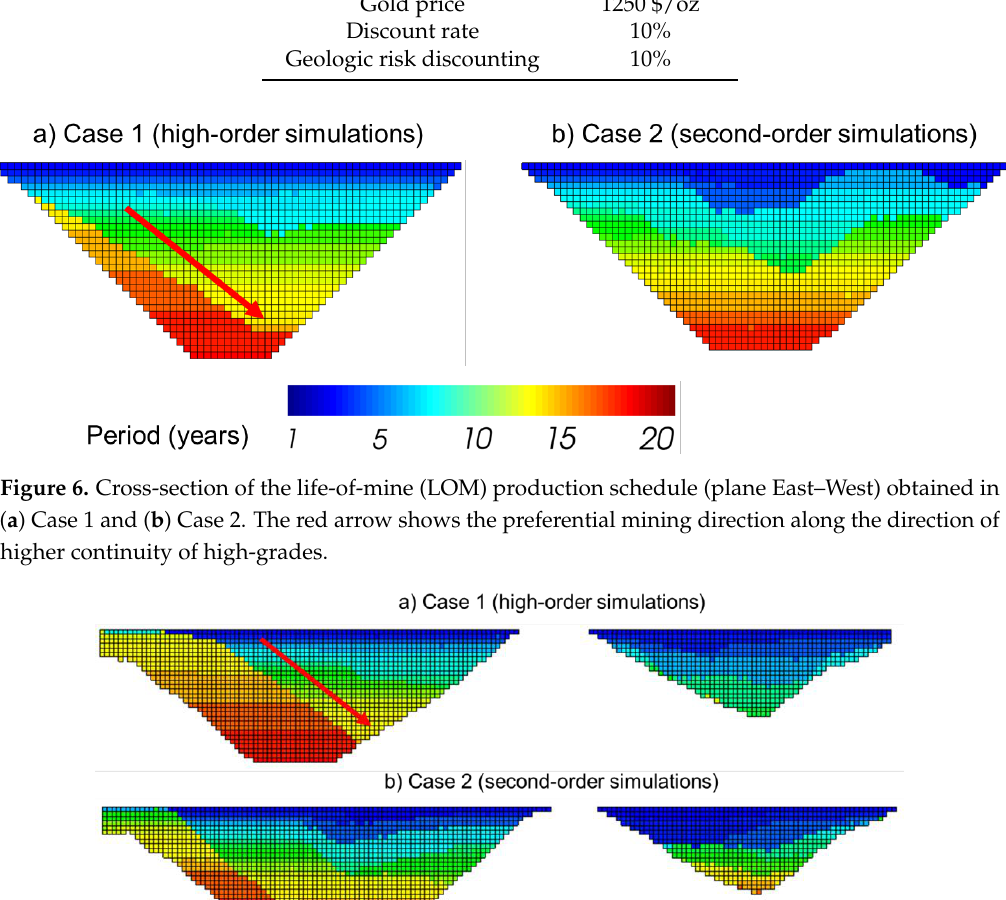
Figure 8. Horizontal sections of the mine production schedule at different elevations for ( a ) Case 1 and ( b ) Case 2. The red circles highlight the differences in pit sizes. Once the production schedules are generated, the risk assessment of achieving production forecasts is calculated by pushing another set of simulations through each LOM schedule and by evaluating related forecasts. The results are presented in terms of P10 and P90, representing the 10th and 90th percentiles of related performance indicators, respectively. Regarding production targets and forecasts, Figure 9a shows the total tonnage mined over the LOM and the cumulative strip ratio for both cases. The production schedule obtained in Case 2 represents, in total, 5% more material mined than in Case 1. This difference reaches 8% at the end of the 10th year to ensure a similar throughput at the mill, Figure 9b. Mining more, in this case, translates to higher waste production, which is quantified by the higher strip ratios presented by Case 2. This can be explained by the spatial disorder (maximum entropy) that Gaussian-based approaches generate with respect to high-grades. Having ore blocks less connected in space forces the optimizer to mine more dispersed high-grade